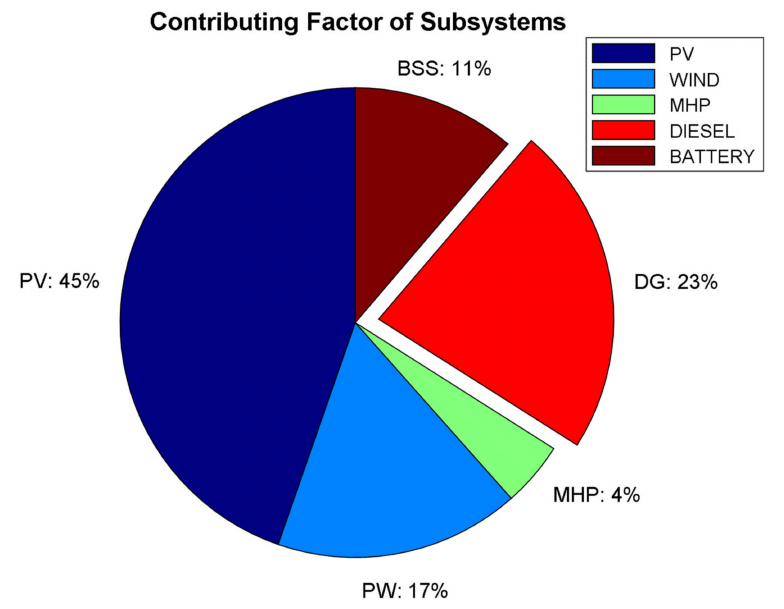
Figure 15. Net power provided by each energy source to the load profile under